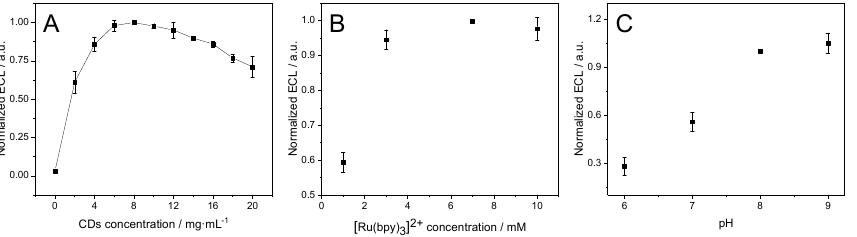
Figure 2. Normalized ECL signals of [Ru(bpy) 3 ] 2+ /CD system obtained by varying (A) the concen- tration of CDs (from 0 to 20 mg/mL) and fixing the concentration of [Ru(bpy) 3 ] 2+ to 7.0 mM in 0.2 M PB pH 8, (B) the concentration of [Ru(bpy) 3 ] 2+ (1, 3, 7 and 10 mM) and fixing CD concentration to 8 mg/mL in 0.2 M PB pH 8, and (C) the pH value (6, 7, 8 and 9) of 0.2 M PB using a 7 mM solution of [Ru(bpy) 3 ] 2+ and 8 mg/mL of CDs. ECL signals were obtained by applying a cyclic potential scan from 0.60 V to 1.20 V or 1.30 V in CSPEs with a scan rate of 10 mV/s. ECL values are obtained from three replicate measurements.